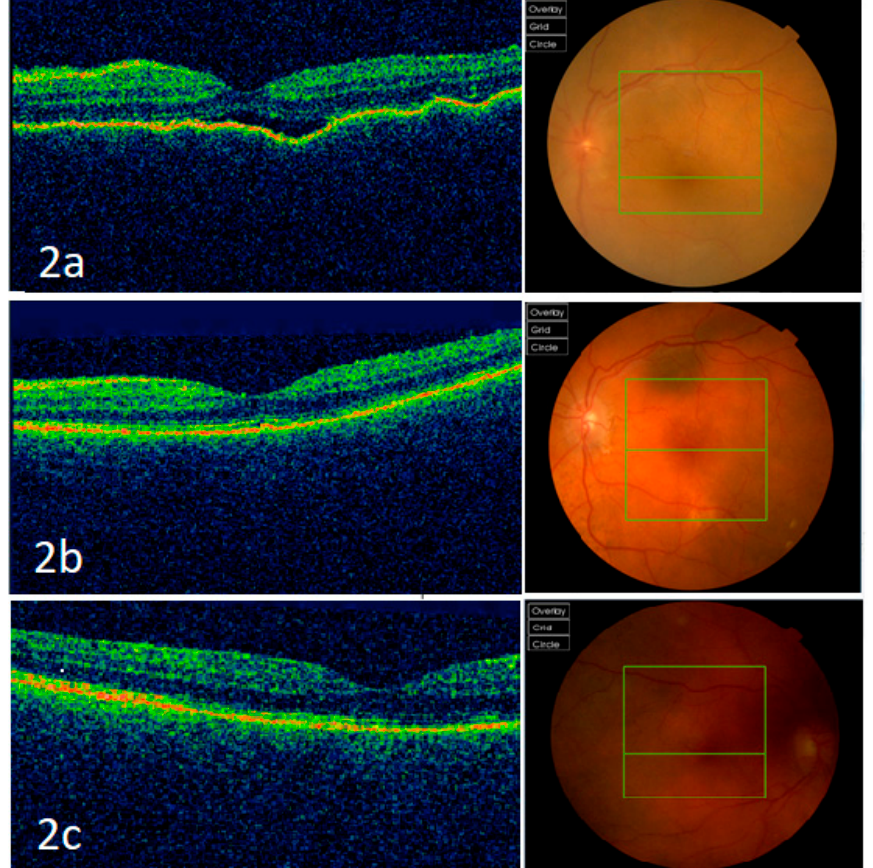
Figure 2. Optical coherence tomography (OCT) macula and fundus photographs. ( a ) Optical coherence tomography (OCT) macula of the left eye showing retinal pigment epithelium irregularities and some subretinal fluid at presentation of sympathetic ophthalmia, and its corresponding fundus photograph. ( b ) OCT macula and the corresponding fundus photograph of the left eye three months after commencing treatment, showing normal appearances. ( c ) OCT macula and the corresponding fundus photograph of the right eye three months after commencing treatment, showing normal appearances.